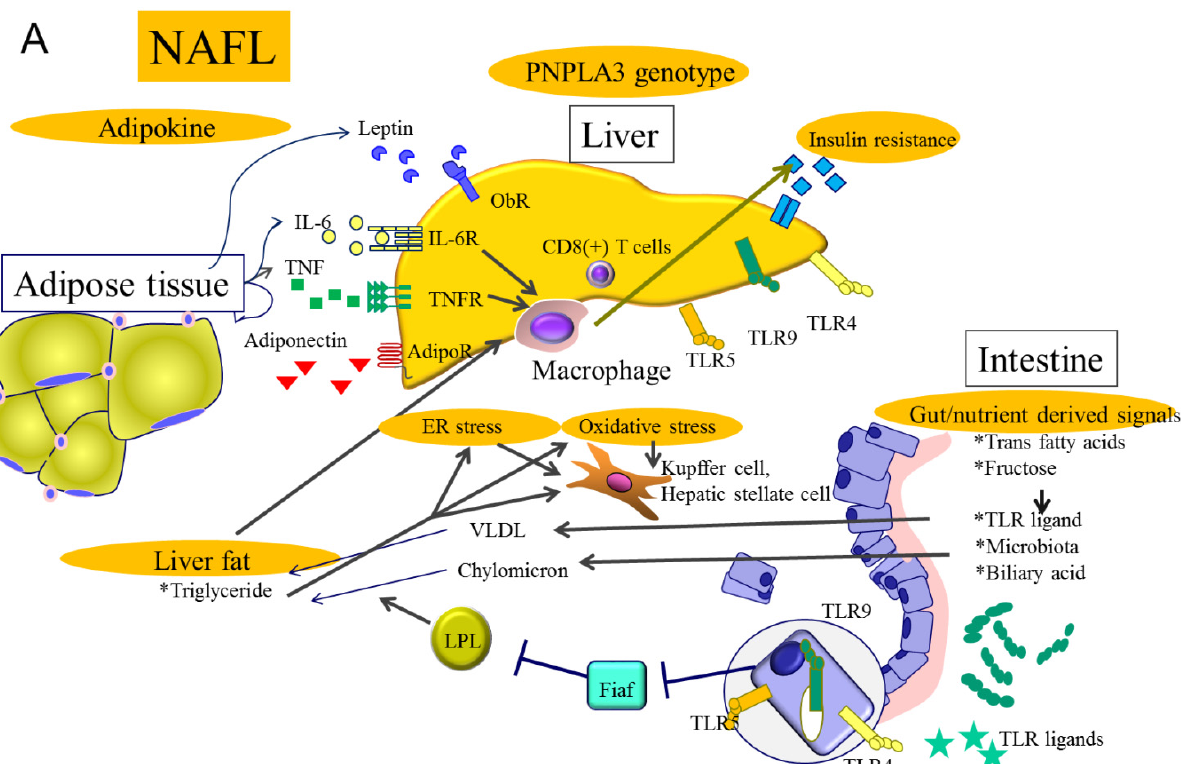
Figure 2. Multiple hits in NAFL and NASH. ( A ) Multiple hits in NAFL are shown. Genome-wide association studies have confirmed the importance of the patatin-like phospholipase 3 (PNPLA3) gene polymorphism in NAFLD. This genetic polymorphism is able to differentiate simple steatosis with or without minimal inflammation and fibrosis progressing to NASH. The gut microbiome has recently been recognized as being involved in NAFLD development. The pattern of microbiome diversity can induce intestinal mucosal permeability and result in lipopolysaccharidemia, which correlates with NASH progression. Enteric bacteria suppress the synthesis of fasting-induced adipocyte factor (Fiaf) resulting in increased lipoprotein lipase (LPL) activity and increased triglyceride accumulation. Obesity and diabetes induce insulin resistance, adipocyte proliferation and changes in intestinal flora. Macrophages play an important role in the induction of inflammation and insulin resistance; ( B ) Ingestion of free fatty acids and free cholesterol induce ER stress and oxidative stress, resulting in hepatic inflammation and fibrogenesis that induces progression to NASH. In some instances, inflammation could precede steatosis, and antitumor necrosis factor (TNF)- α antibody improves steatosis in ob/ob mice. CD4(+)T cells are found after NASH development. Adipokines such as IL-6 and TNF- α produced by adipocytes affect hepatocyte fat content and the liver inflammatory environment. Mallory-Denk bodies are large eosinophilic hepatocellular cytoplasmic protein aggregates containing CK (cytokeratin)-18, which is a hallmark of alcoholic hepatitis and NASH. Heading numbers are consistent with those used in the main